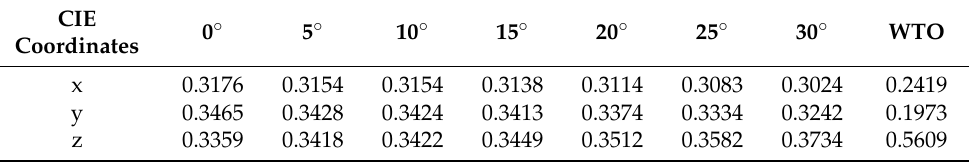
Table 1. CIE coordinates verse tilt